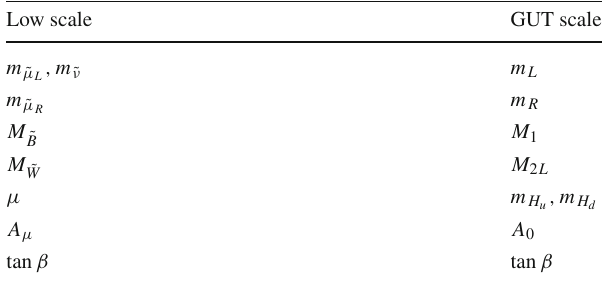
the other diagrams represent the mixing between different Neutralino species. In the top-right diagram, there is another loop which is formed by the particles given in the parentheses